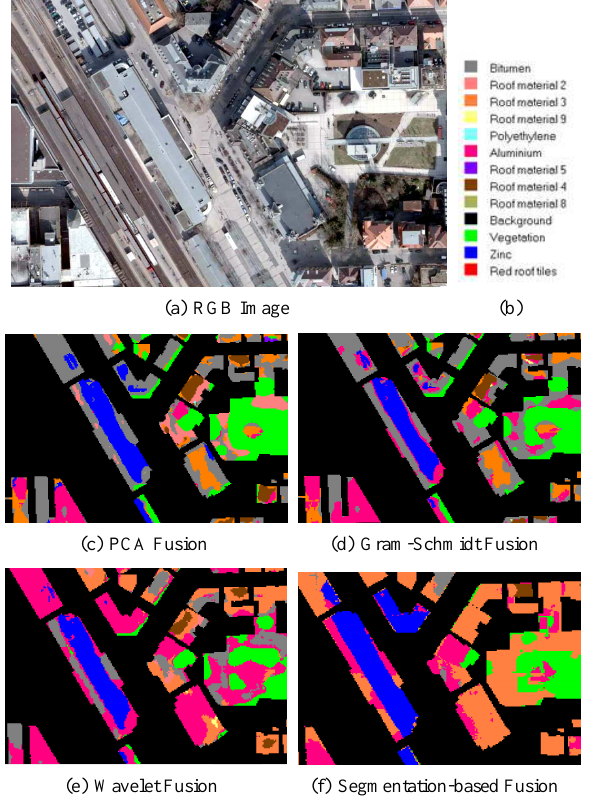
Figure 9: Classification Example